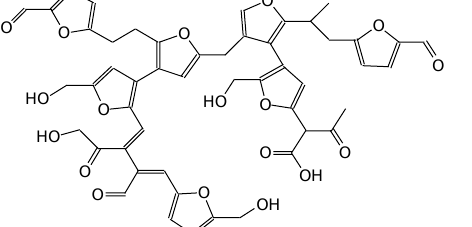
O OO OO OO H H H 810 Da (Calculated 810 Da) without Na+ (180 °C Oxidized, 180 °C not oxidized, 150 °C) 833 Da (Calculated 833 Da) with Na+ (180 °C Oxidized, 180 °C not